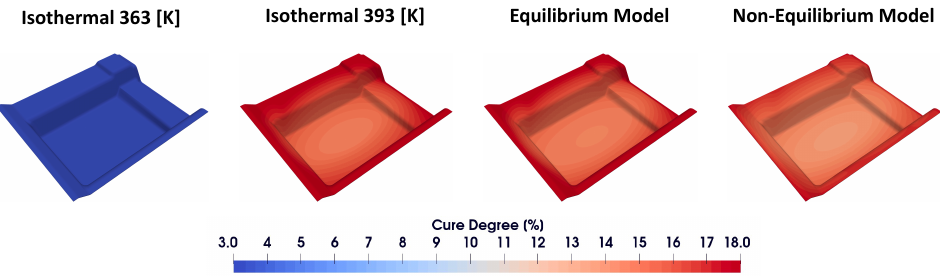
Figure 9. Predicted cure degree distribution at 10s into the curing stage using different energy modelling approaches.